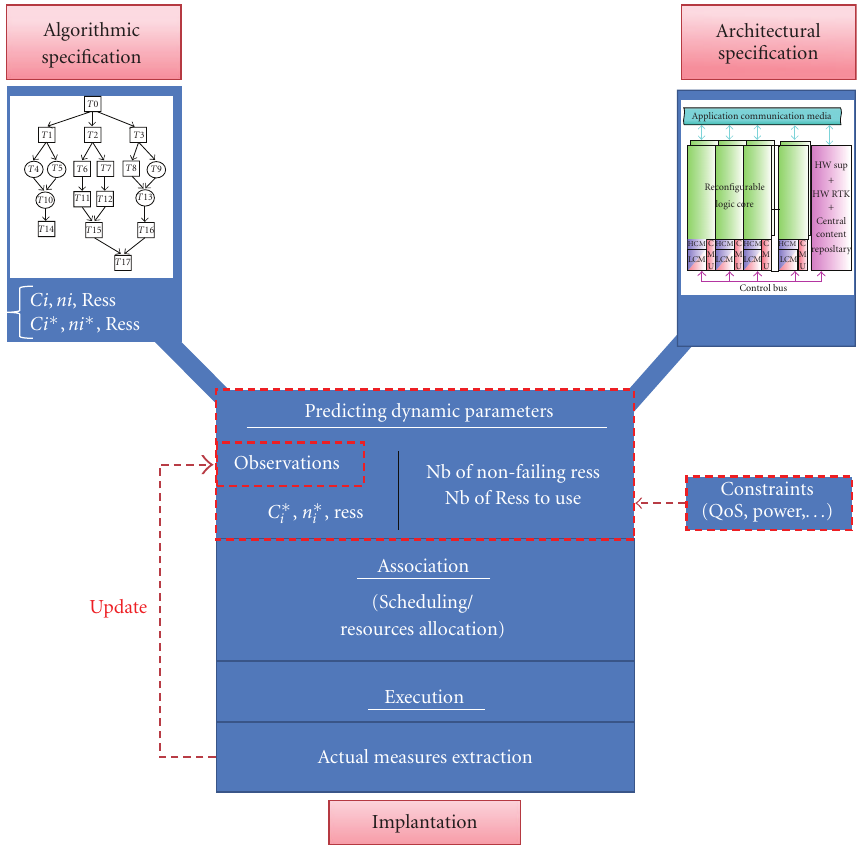
Figure 8: Scheduling flow on OLLAF